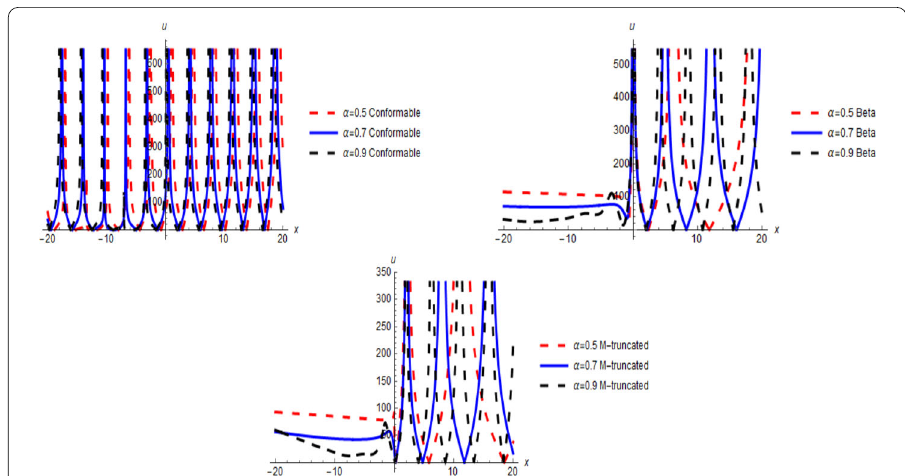
Figure 9 2D-plot of u 8 for different derivatives at t = 1 for different values of α